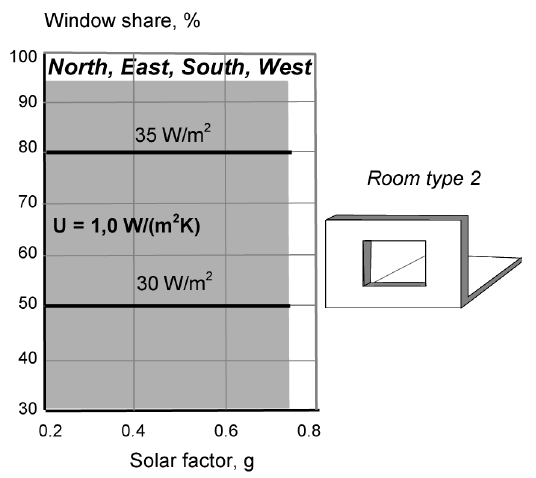
Fig. 15. Possible combinations of window glass share and solar factor for room type 2 for a maximum heating power demand of 2 30 or 35 W/m